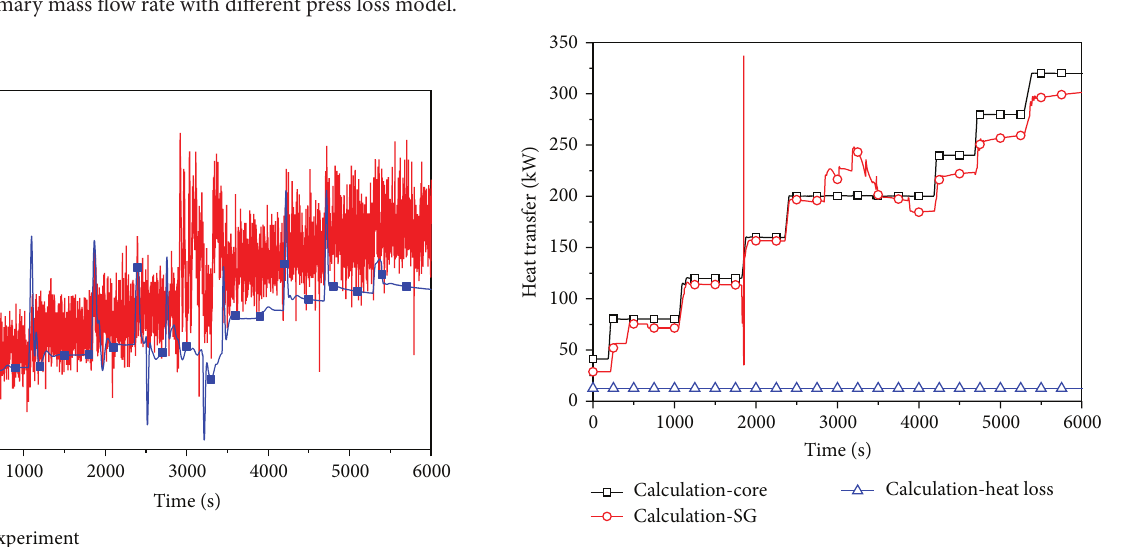
Figure 11: Various heat transfers at the primary system.